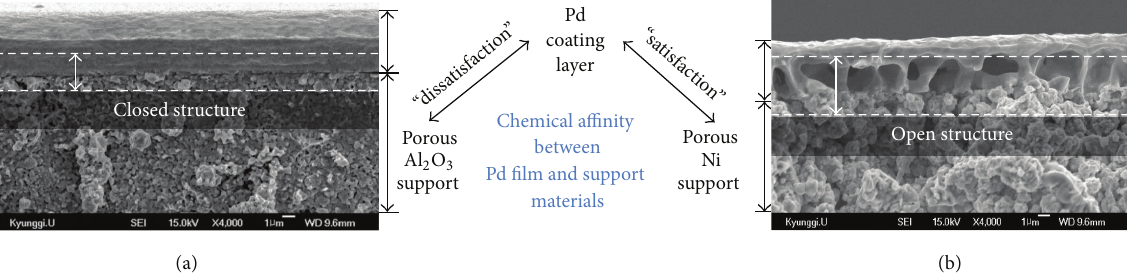
Figure 1: Chemical affinity between Pd film and support materials: (a) closed structure formed at interface between Pd film and porous Al 2 O 3 support; (b) open structure formed at interface between Pd film and porous nickel support.